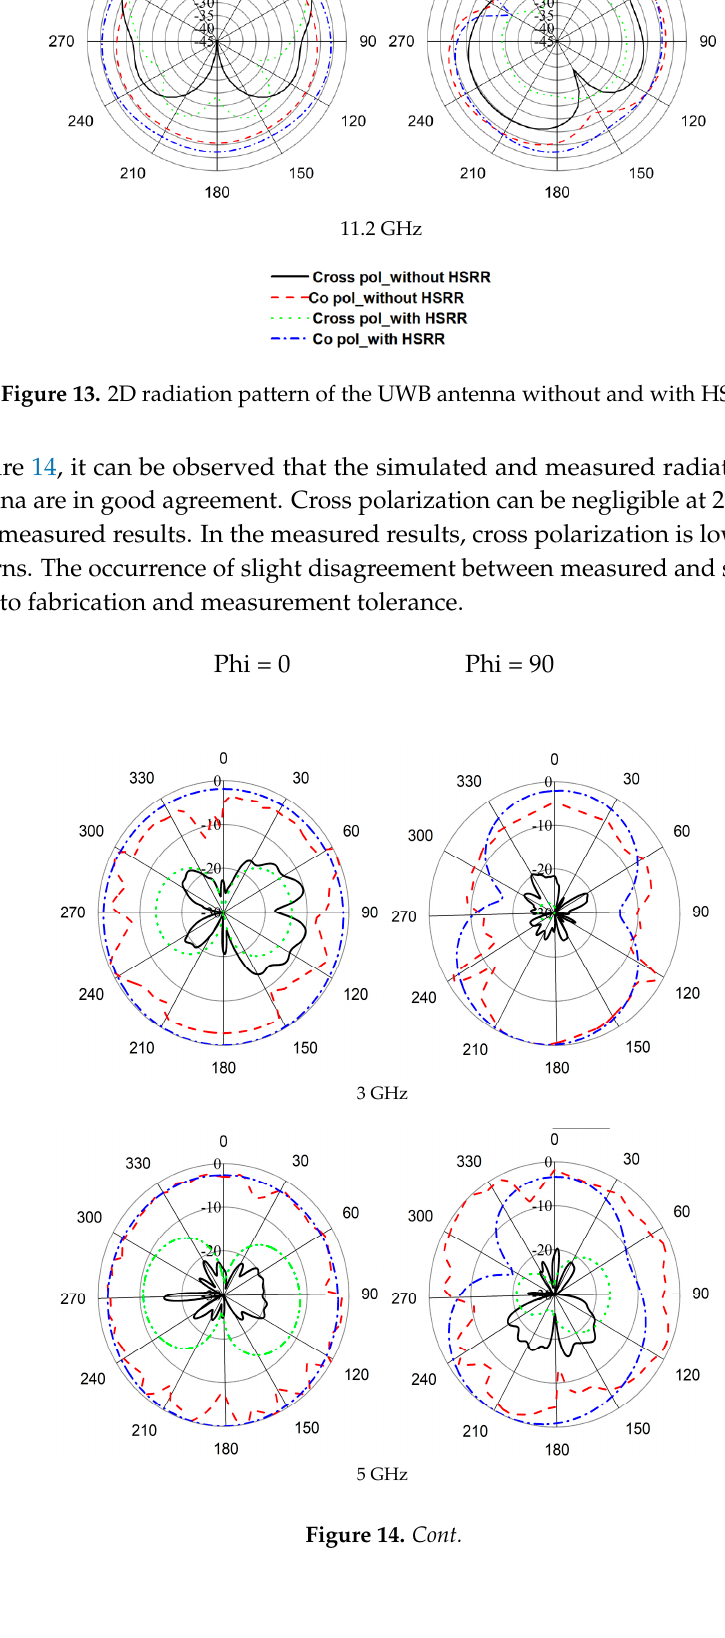
11.2 GHz Figure 14. Simulated and measured radiation patterns of the proposed UWB antenna.